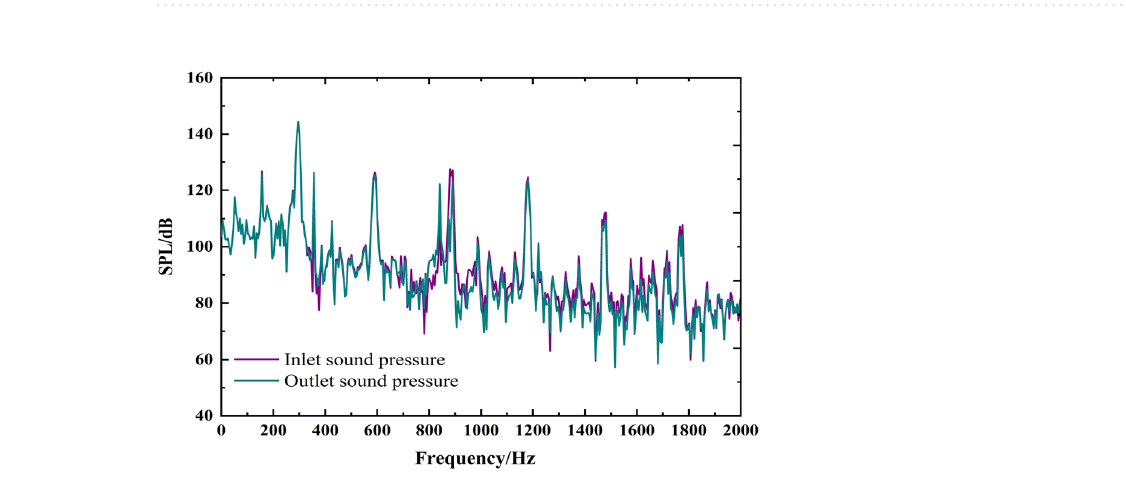
Figure 5. The spectrum of infield noise by fluid excitation.